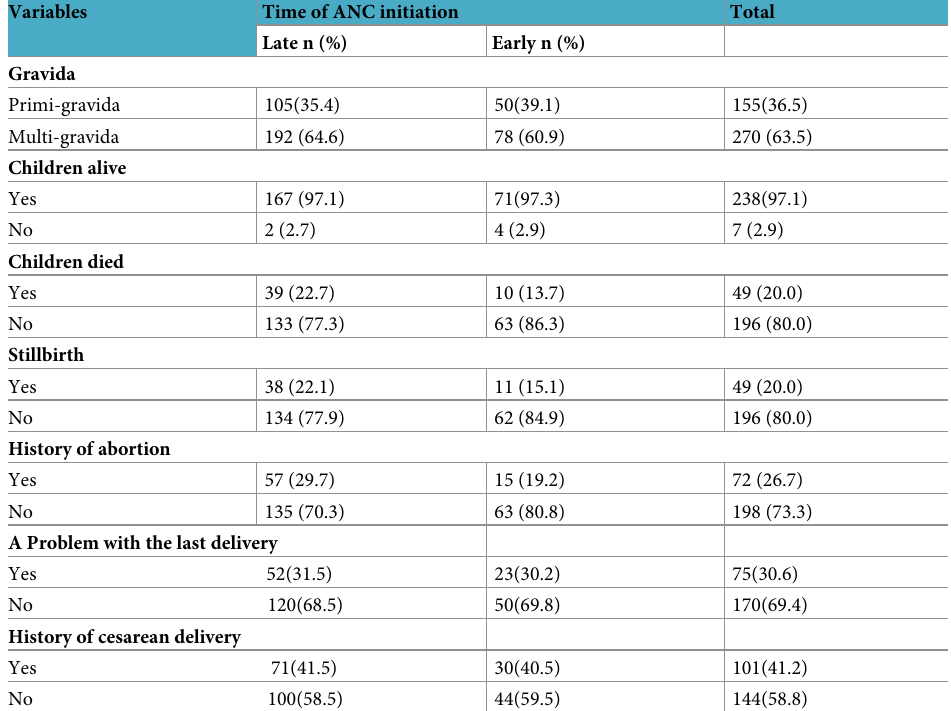
Table 2. Obstetrics history of the study participant’s visits to the health institution for ANC service in Mizan- Aman town, southwest Ethiopia 2021.